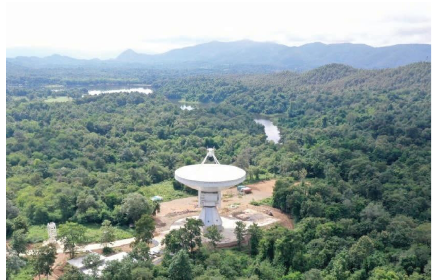
Figure 10: Tai national radio telescope